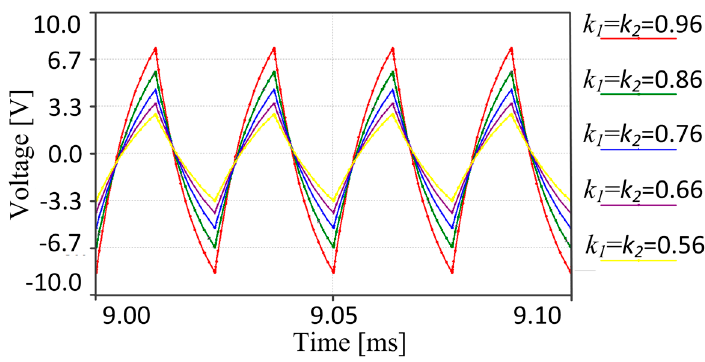
Figure 9. Simulation by Multisim.